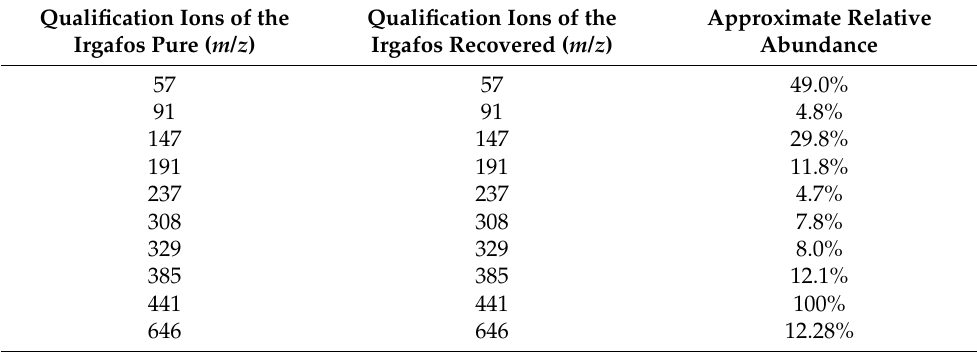
Table 4. Fragment mass and approximate relative abundance of pure and recovered Irgafos.